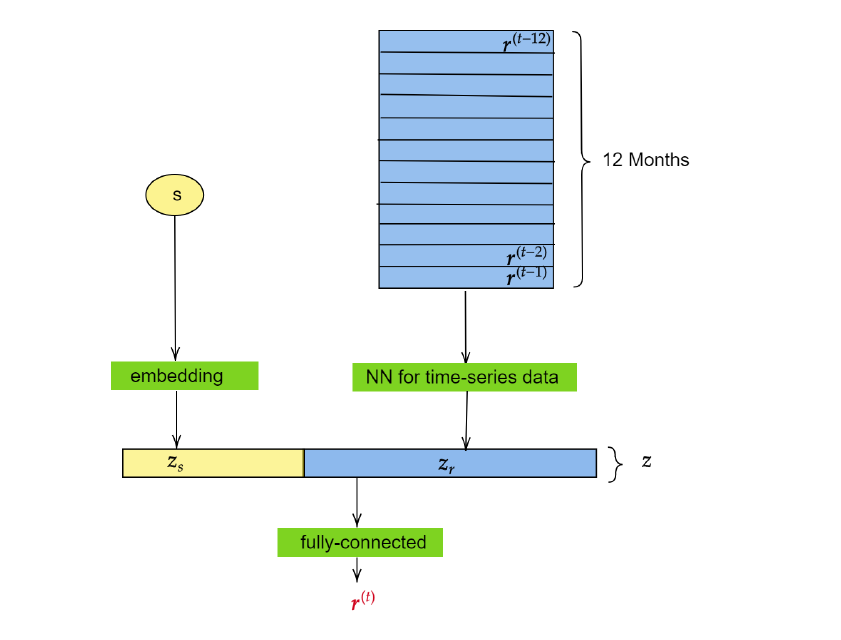
Figure 2. A graphical diagram of the proposed neural network model.